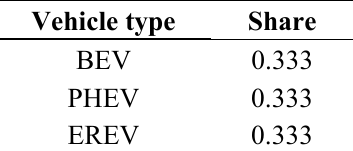
Table 9. EV types definition.